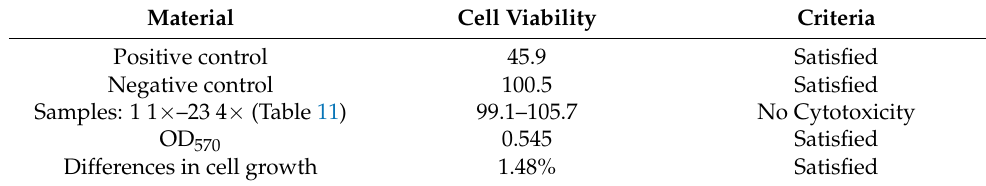
Table 11. Summary of cytotoxicity results.